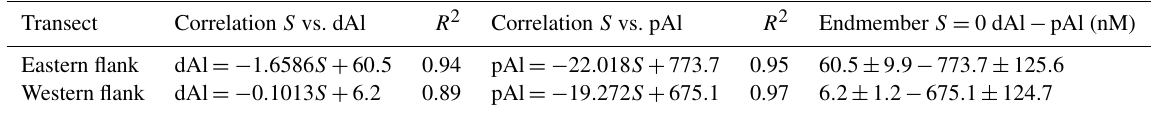
Table 1. Correlations between salinity ( S ) and dAl and pAl for the eastern and western transects off Greenland. Endmember salinity 0 estimations for dAl and